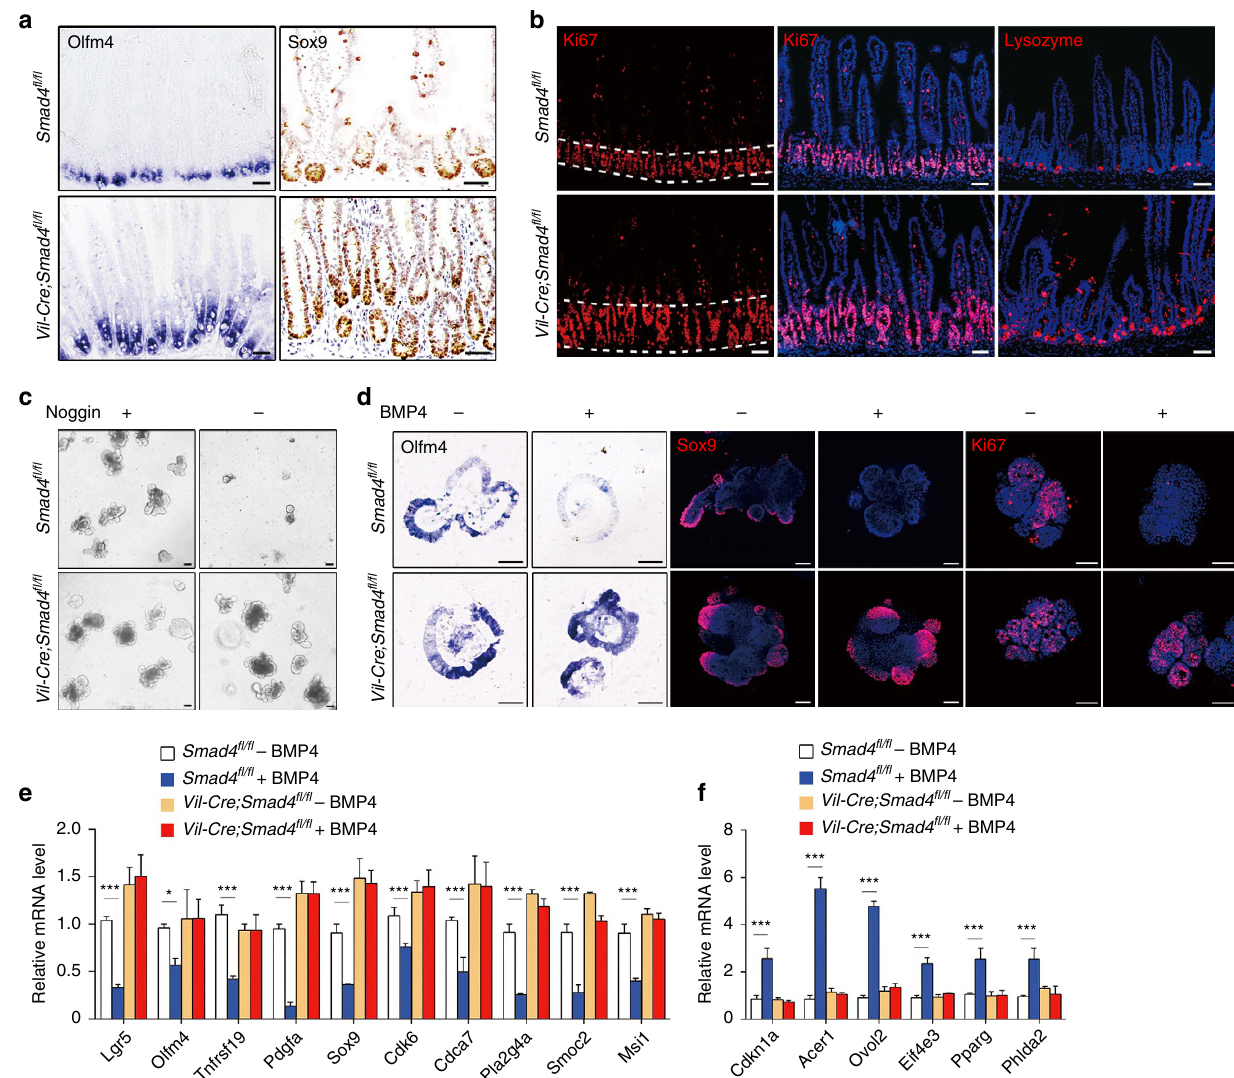
Figure 7 | Smad4 mediates the negative regulation of BMP on Lgr5 þ stem cell self-renewal. ( a ) Olfm4 in situ hybridization and Sox9 staining in intestines from 1-month-old Smad4 fl/fl and Vil-Cre;Smad4 fl/fl mice. Images are representative of n ¼ 5 mice per genotype. ( b ) Ki67 and lysozyme staining in intestines from 1-month-old Smad4 fl/fl and Vil-Cre;Smad4 fl/fl mice. Dotted lines delineate the region of crypts. Nuclei were counter-stained with 4 0 ,6-diamidino-2-phenylindole (DAPI). Images are representative of n ¼ 5 mice per genotype. ( c ) Intestinal organoids derived from Smad4 fl/fl and Smad4 KO ( Vil-Cre;Smad4 fl/fl ) mice were cultured in ENR (EGF, Noggin and R-spondin) or ER medium for 5 days and photographed. Images are representative of three independent experiments. ( d ) Intestinal organoids derived from Smad4 fl/fl and Smad4 KO ( Vil-Cre;Smad4 fl/fl ) mice were treated with BMP4 for 36h followed by Olfm4 in situ hybridization, Sox9 staining and Ki67 immunofluorescence staining. Nuclei were counter-stained with DAPI. Images are representative of three independent experiments. ( e , f ) Smad4 fl/fl and Smad4 KO ( Vil-Cre;Smad4 fl/fl ) organoids were treated with BMP4 for 4h and the mRNA level of indicated genes were measured by quantitative RT–PCR. Data represent mean ± s.e.m of three independent experiments. * P o 0.05, *** P o 0.001 by Student’s t -tests. Scale bars, 50 m